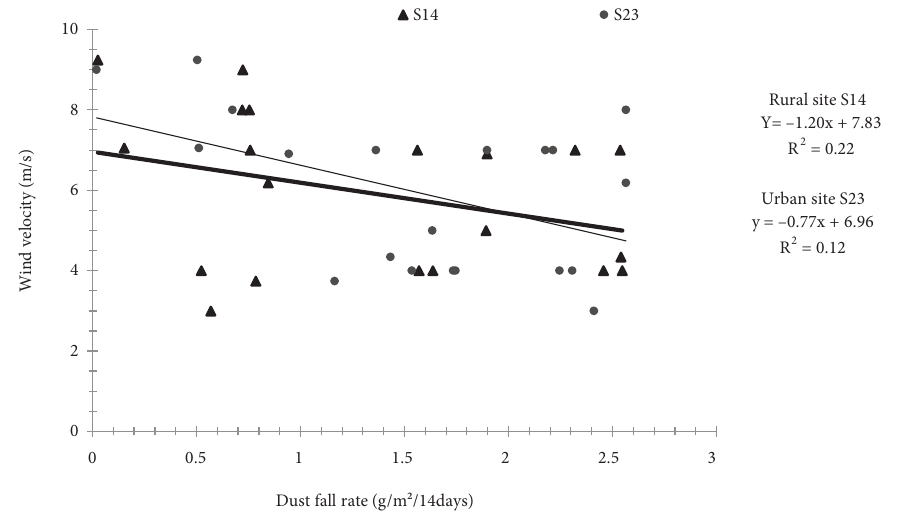
Figure 7. Regressions between wind velocity and biweekly flow deposits trough the two studied sites (S14 and S23)